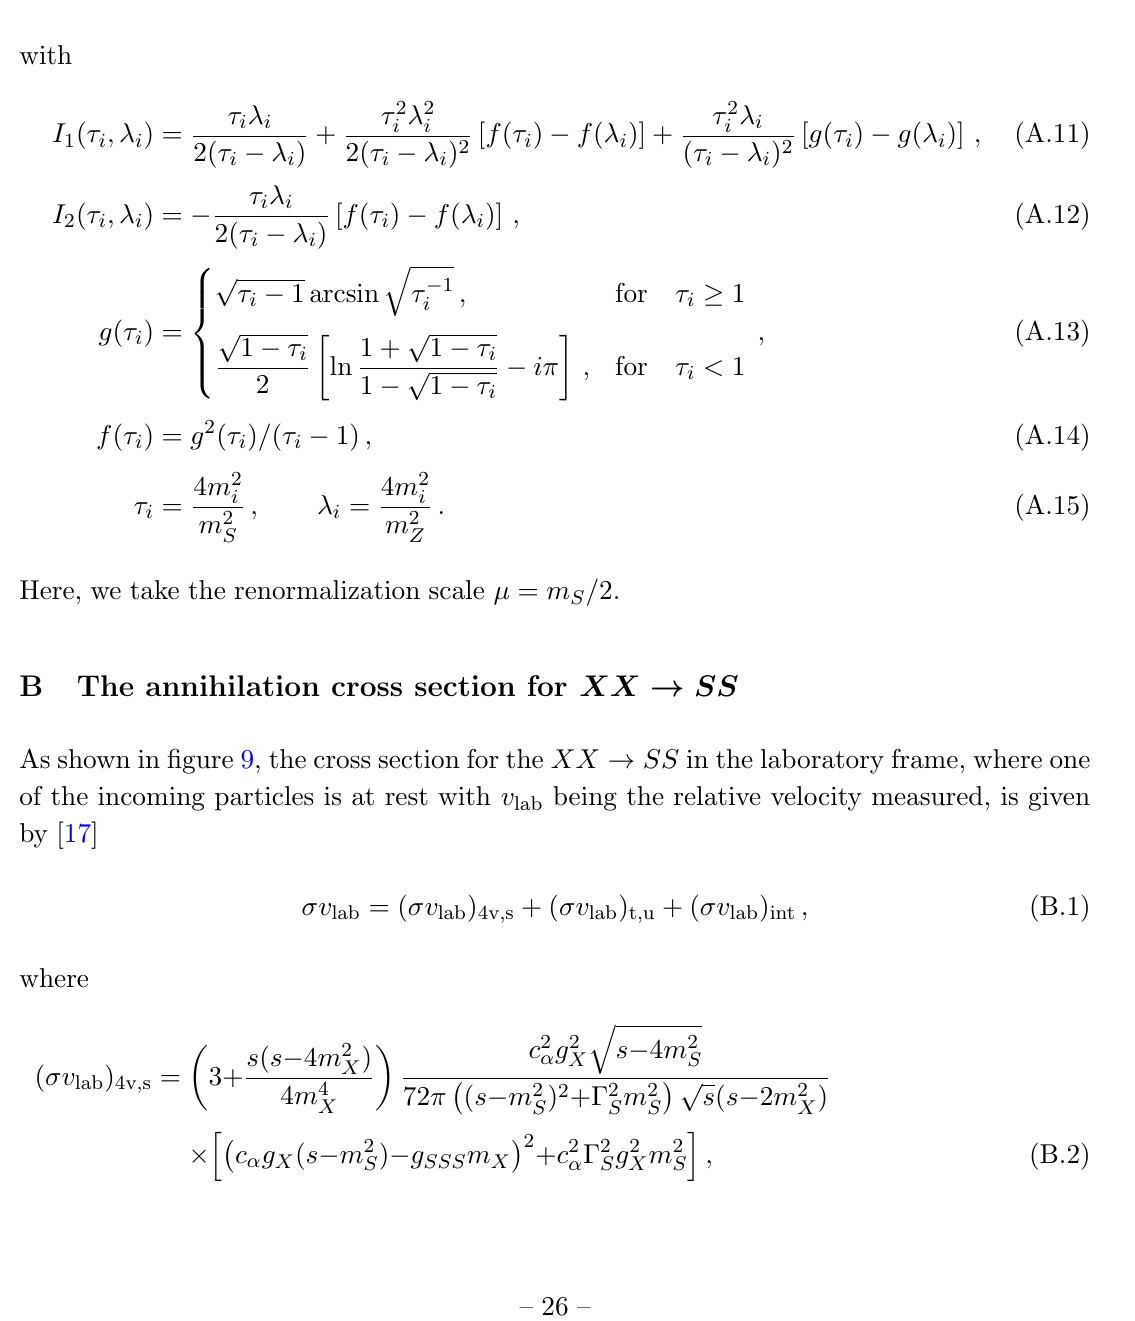
Figure 9 . The dominant contributions to the DM annihilation cross section, where (a), (b), (c), and (d) are diagrams for the 4-vertex, s -, t -, u -channels, respectively. Here p i are the momenta of the